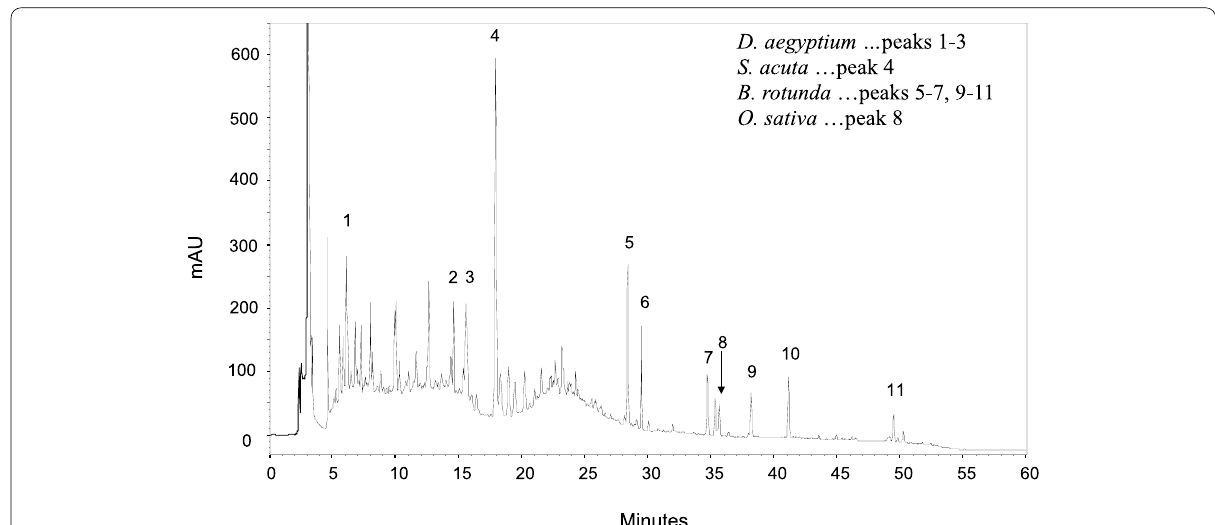
Fig. 2 Chromatogram of the contents of Sao Thong Tai (STT) capsules with characteristic peaks representing the active ingredients: peaks 1-3) D. aegyptium ; peak 4) S. acuta ; peaks 5-7, 9-11) B. rotunda ; and peak 8) O. sativa . Each capsule contained the following markers: peak 7, pinocembrin 0.28 mg; peak 9, cardamonin 0.29 mg; and peak 10) pinostrobin 0.43 mg. The chromatographic conditions were characterized as follows: stationary phase, VDSpher PUR 100 C18-E, 250 x 4.6 mm i.d., 5 μm; mobile phase, A: 2% (v/v) acetic acid in water; mobile phase, B: acetonitrile; gradient: 0